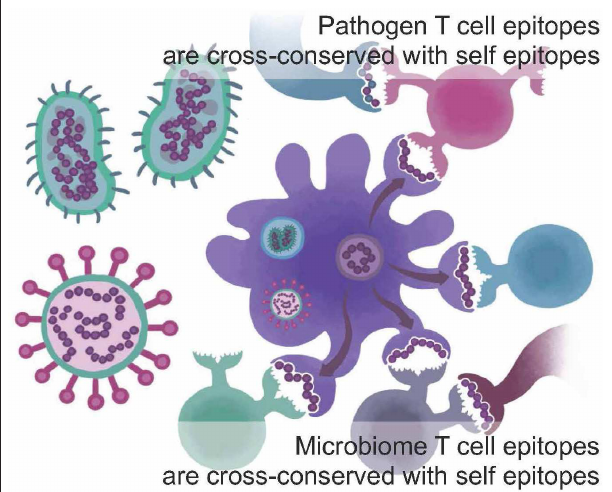
FIGURE 1 | Immune camouflage. T cell epitopes found in the sequences of viruses, bacteria, and parasites and/or in the human microbiome may be conserved with highly prevalent T cell epitopes found in self-proteins from the human genome; cross-conservation may be observed at the TCR face for peptides that bind to the same HLA but do not have identical sequences. This may enable a pathogen to trigger “ignorance” or active tolerance from T cells that have been trained on self-epitopes. Adapted from Moise et al.